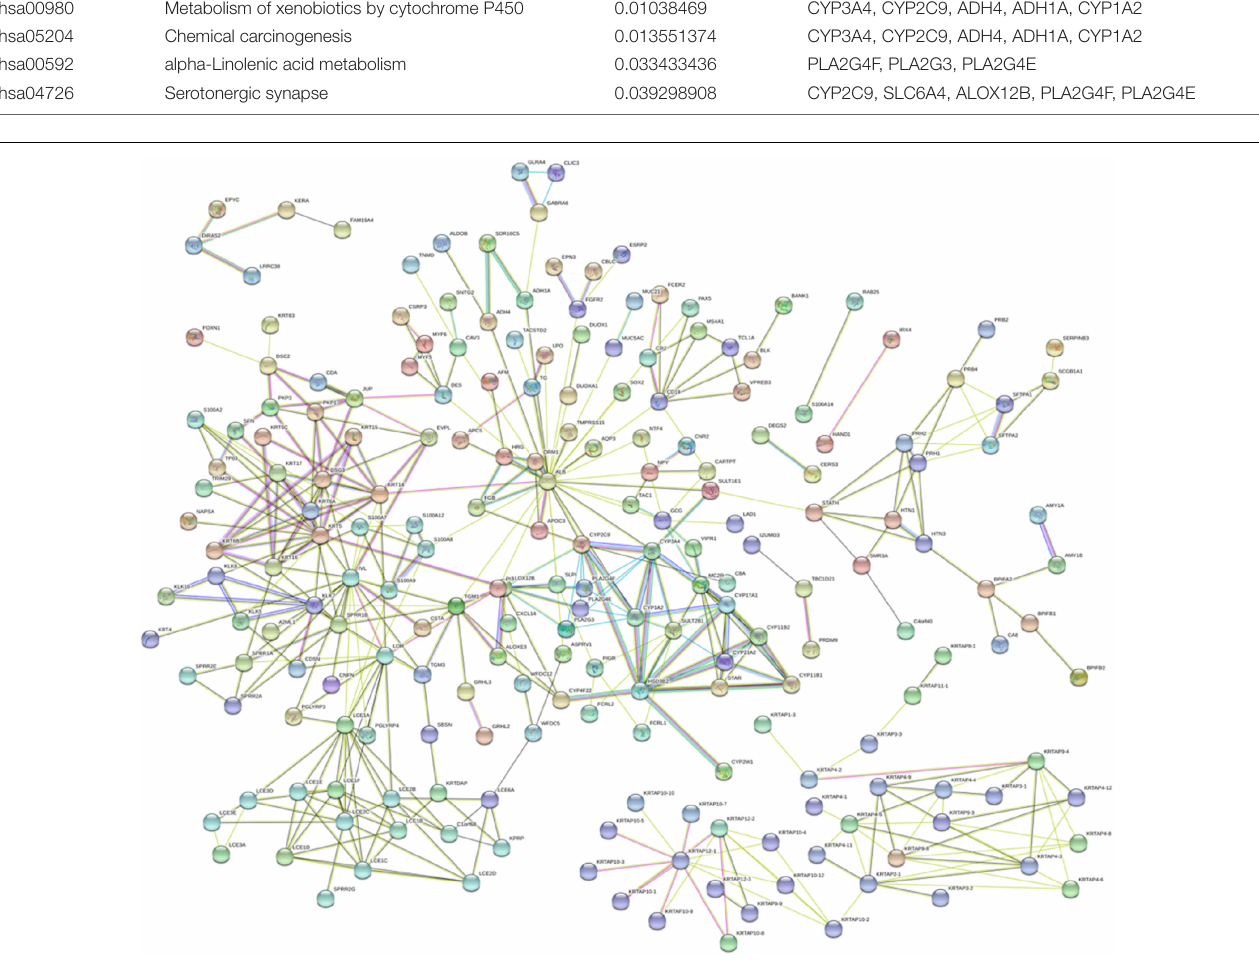
FIGURE 4 | The PPI network constructed by the website STRING (https://string-db.org/). A total of 322 proteins are presented with color nodes; interactions are represented with edges. Only edges with weight (w) above a threshold of 0.4 are displayed.